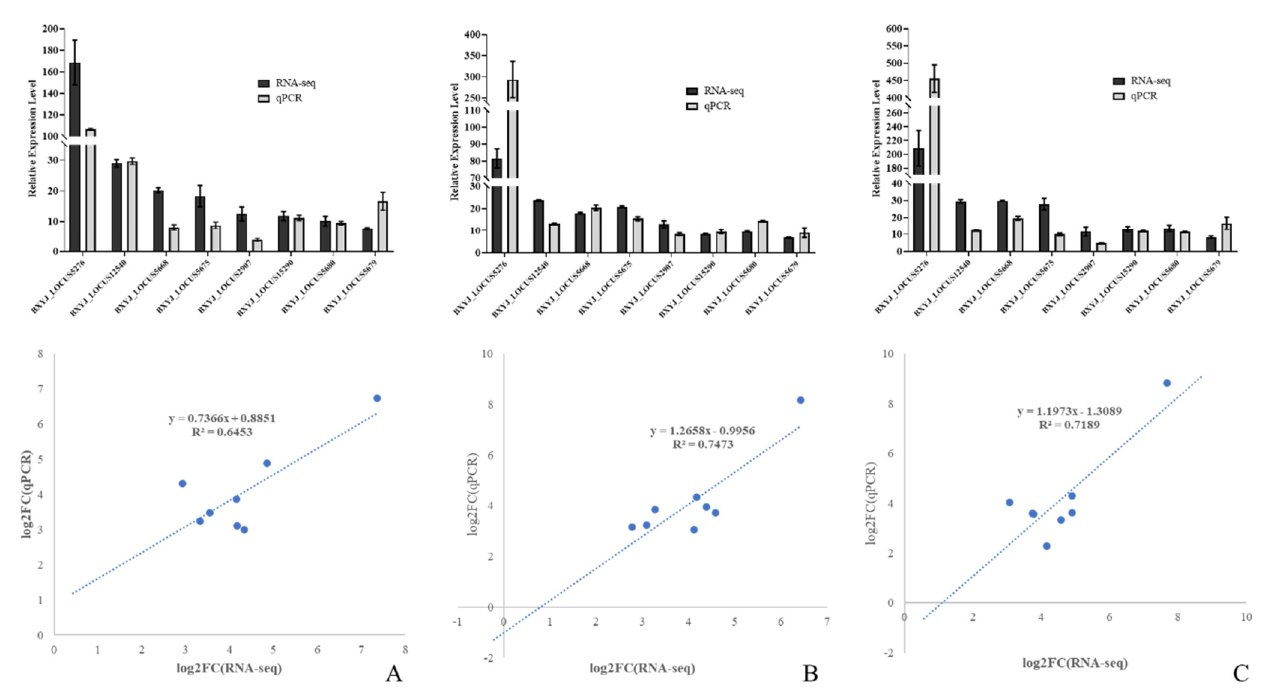
Figure 10. Expression of differentially expressed genes in CK vs. T24 ( A ), CK vs. T30 ( B ), and CK vs. T36 ( C ). T36 ( C